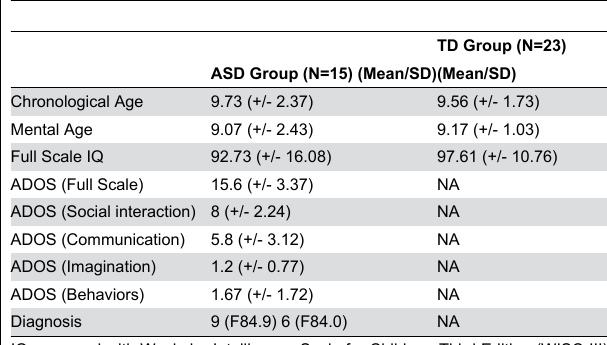
Table 1. Subject Demographics for Children Participating in the